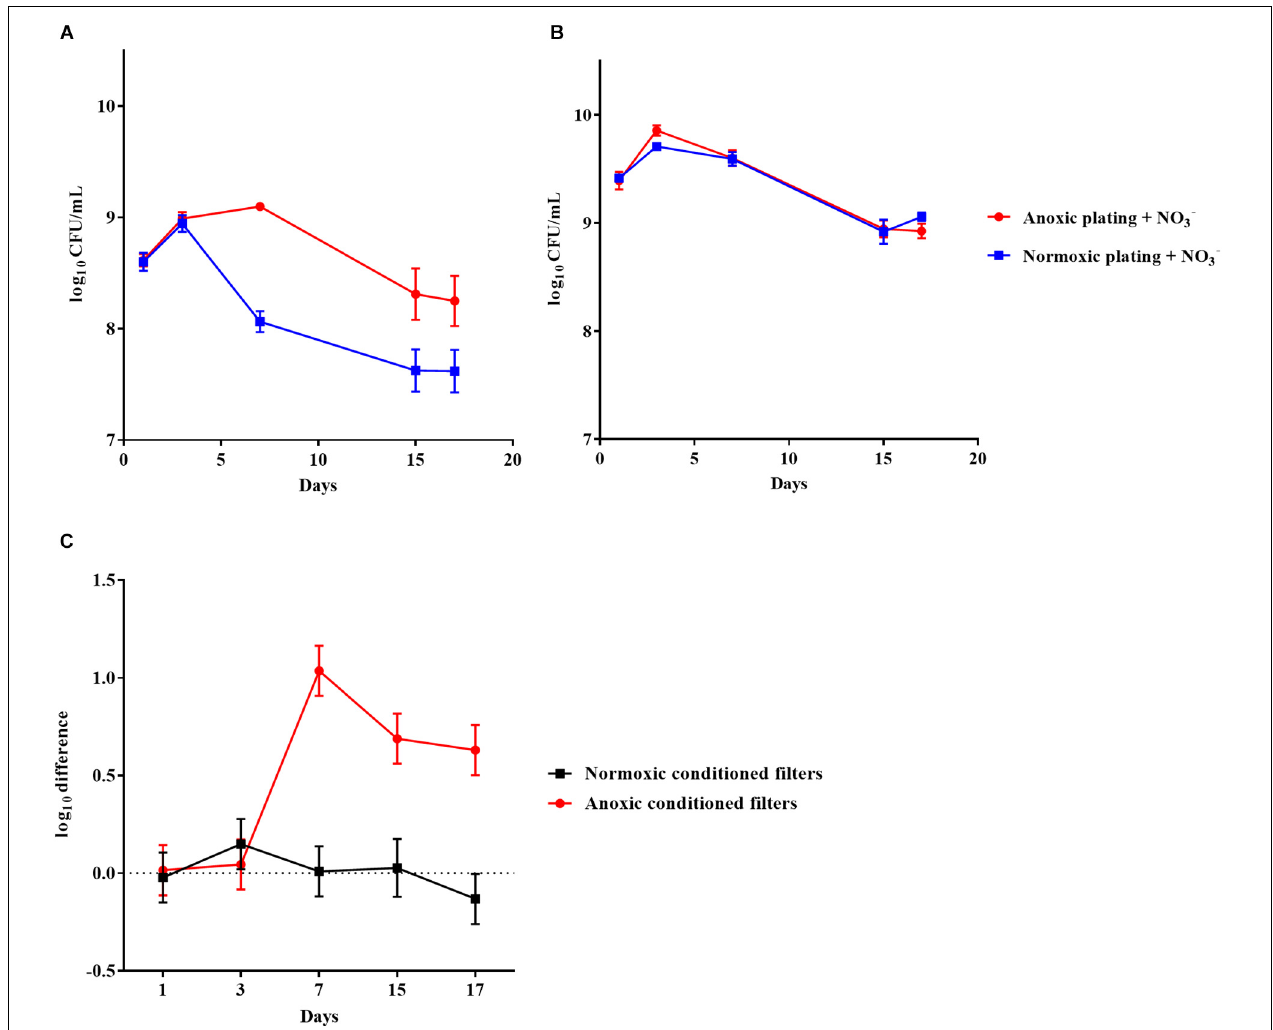
FIGURE 9 | An oxygen intolerant subpopulation of Staphylococcus aureus (methicillin susceptible) was generated in the filter biofilm model. Normoxic and anoxic colony forming units per milliliter (CFU/mL) of Staphylococcus aureus over 17 days from anoxically (A) and normoxically (B) conditioned filters. Symbols with error bars indicate the mean ± SEM ( n = 4). + NO 3 - refers to the addition of 10 mM KNO 3 to LB agar plates. The log difference (C) represents the difference in mean log CFU/mL between plating methods from the normoxically and anoxically conditioned filters, respectively. The log difference was significantly higher ( p < 0.001, linear regression) in the anoxically conditioned filters than the normoxically conditioned. Symbols with error bars indicate the mean + confidence